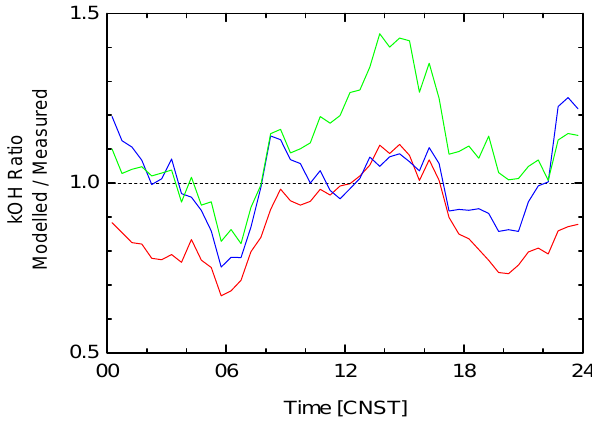
Fig. 9. Ratio of modelled to measured k OH versus time of day. Red line: model base case. Green line: model plus additional radical recycling by X, all days. Blue line: model plus additional radical recycling by X, days with northerly wind (13/14/24/25 July) ex-